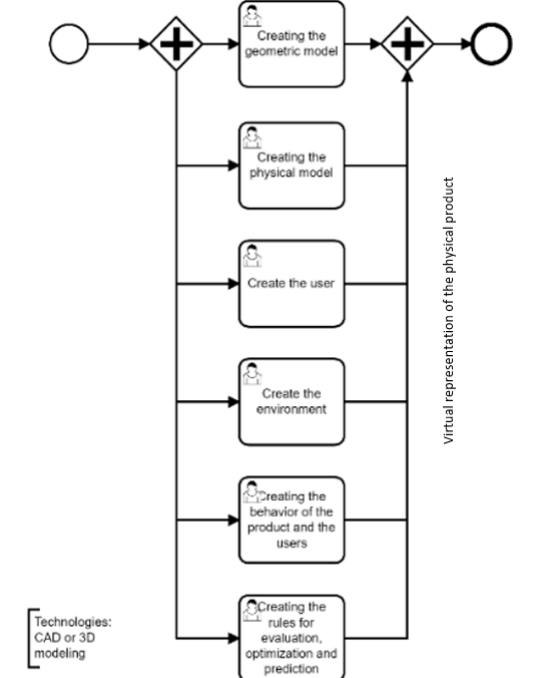
Variant 2: Sequence of steps for creation of a virtual product representation.